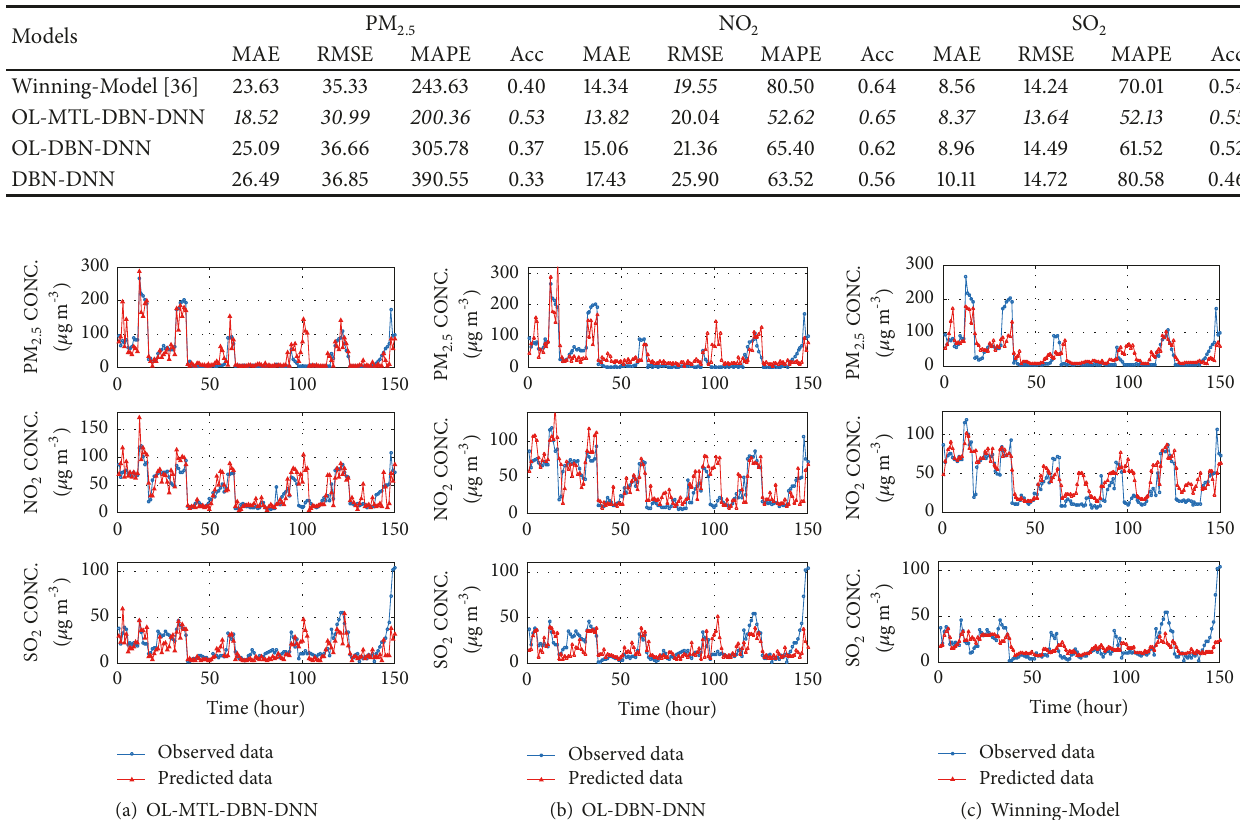
Table 3: Comparison among different models.